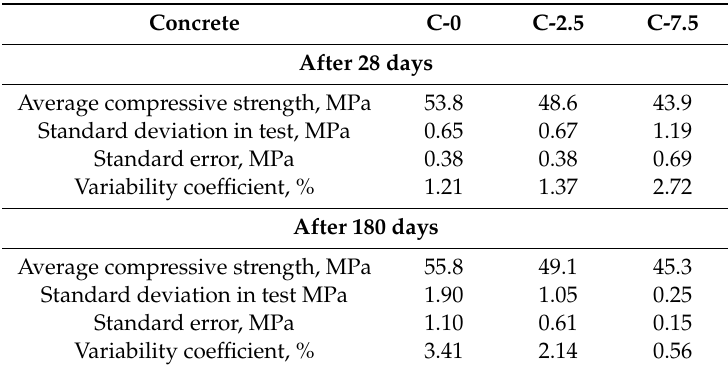
Table 10 specifies selected statistical parameters for analysed results of compressive strength. Table 10. Basic statistical parameters. Features of Table 10. Basic statistical parameters. Features of concrete.